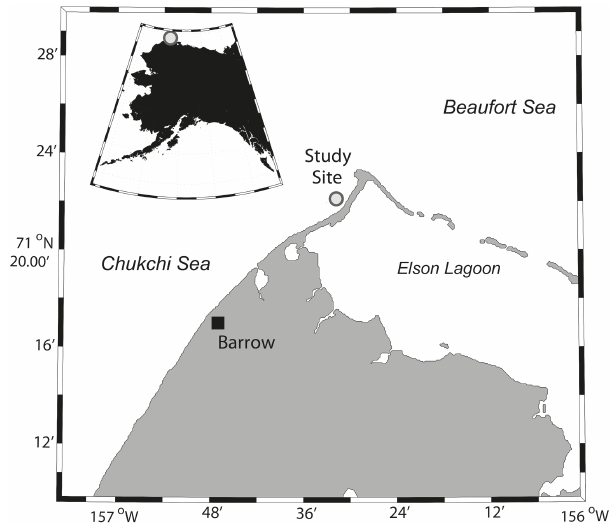
Figure 1. The study site, north of Barrow (Alaska,